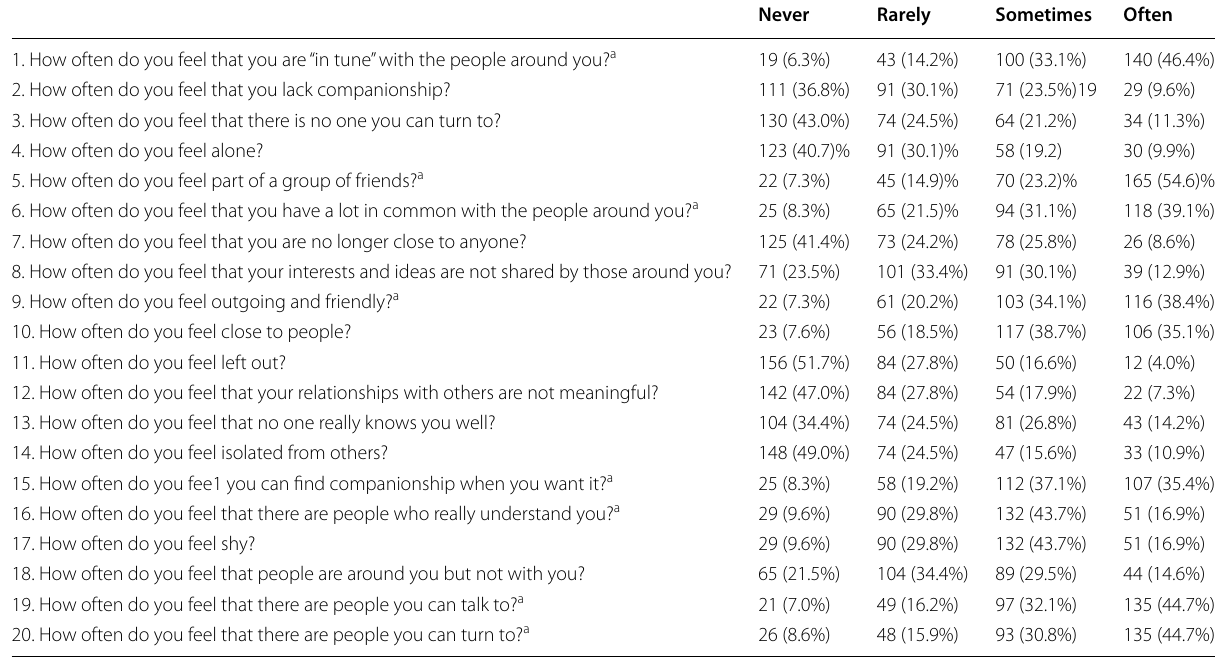
Table 5 Loneliness scale items among the studied participants